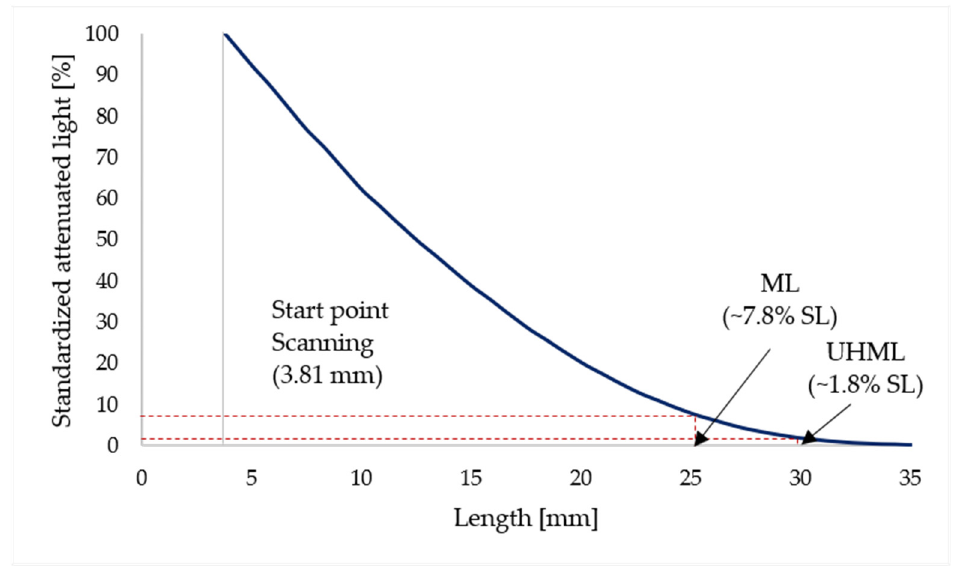
Figure 2. An illustration of a typical fibrogram and the current HVI measurements extracted from it [25].